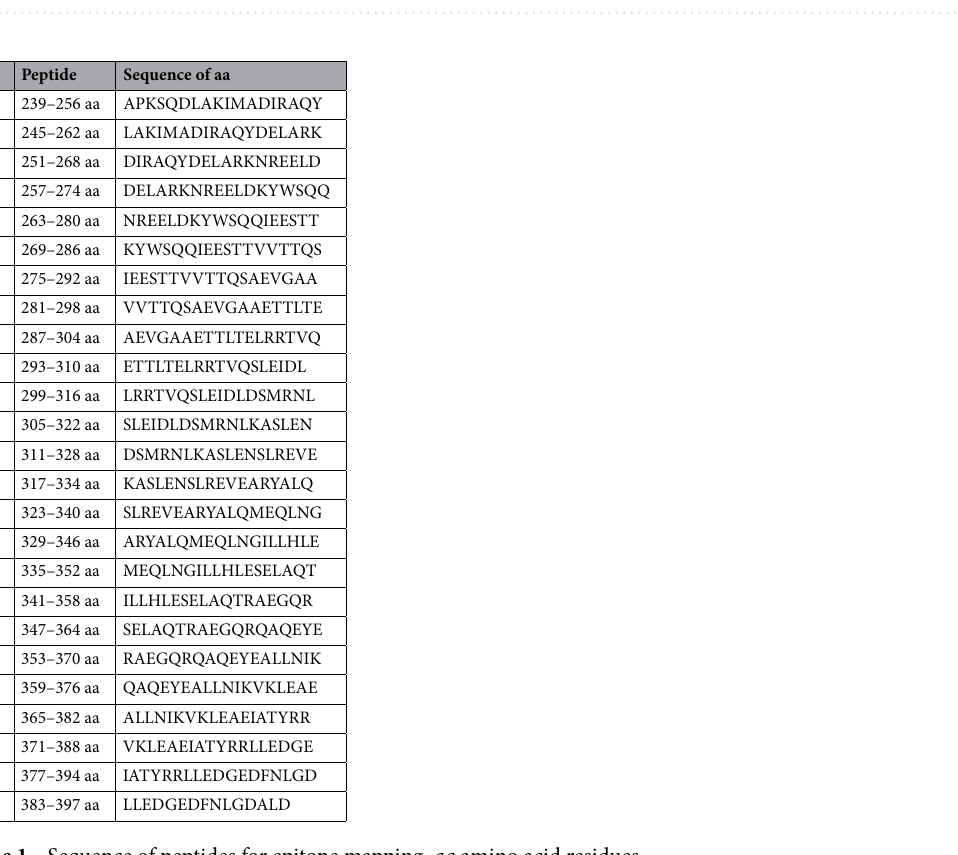
Figure 2. Epitope mapping of the K18-328 antibody. The reactivity of K18-328 antibody to a total of 25 peptides, which consist of a series of 158 overlapping peptides, each of which is 18 aa residues in length. Peptide number corresponds to the number in Table 1.